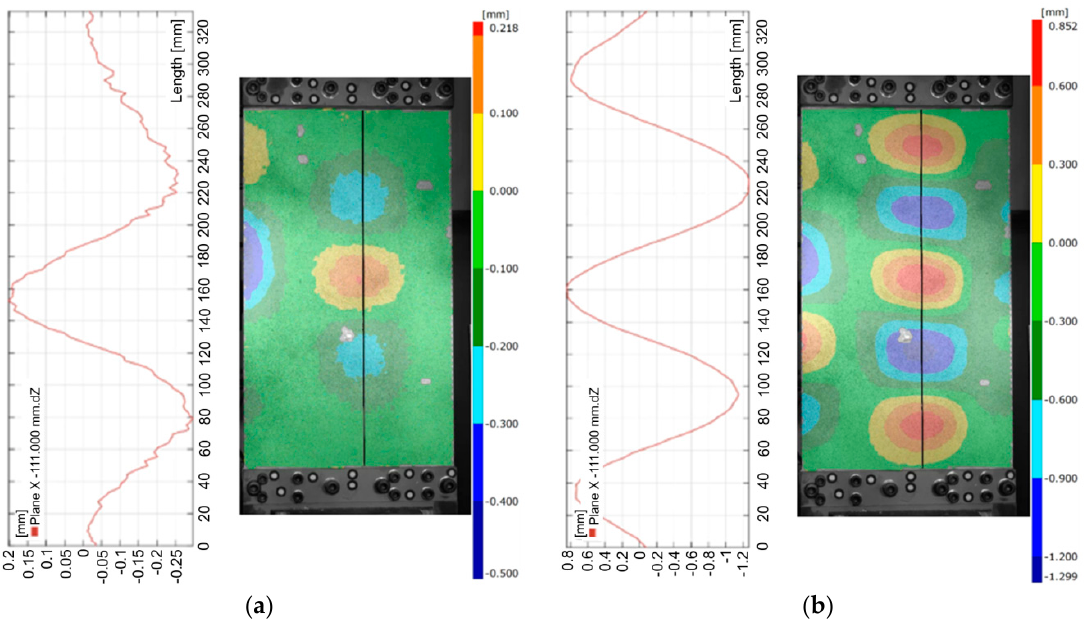
Figure 4. The deflection of riveted panels subjected to a compression load of 1800 N ( a ) and 9000 N ( b ) obtained using the three-dimensional digital image correlation (DIC) technique.